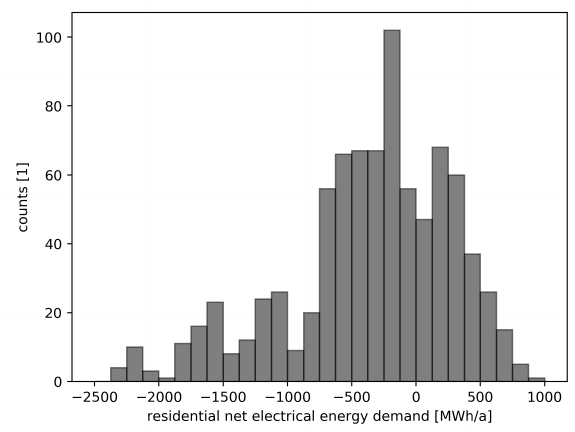
Figure 7. Annual electrical energy demand of the morphological analysis scenario space.